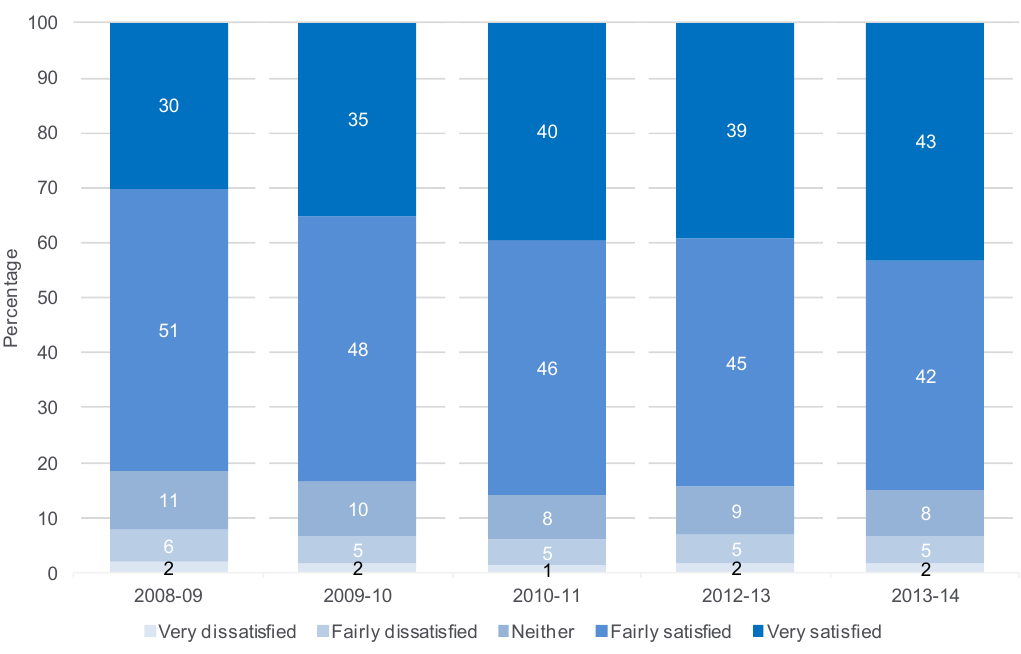
- Table 12: Satisfaction with local area, 2008-09 to 2013-14